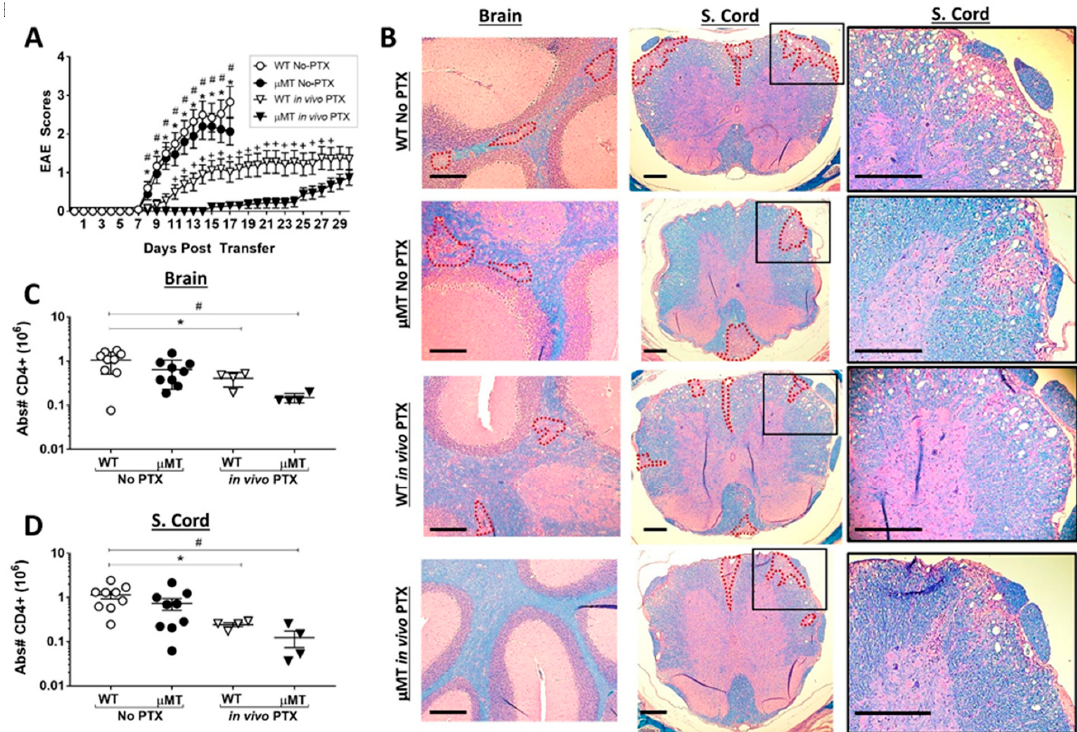
Figure 5. B-cell-deficient mice were protected against Th17-EAE when treated with PTX. ( A ) Clinical scores of WT and B-cell-deficient ( µ MT) mice with Th17-EAE treated with PTX (250 ng IP) (in vivo PTX) or PBS (No PTX) on day 0 and 2 post-transfer; n = 25–30/group; results compiled from 5 independent experiments. Mann–Whitney tests were performed between each group to determine statistical significance (* p < 0.05, WT No PTX vs. WT in vivo PTX; # p < 0.05 WT No PTX vs. µ MT in vivo PTX; + p < 0.05, WT in vivo PTX vs. µ MT in vivo PTX). ( B ) Representative brain and spinal cord sections of WT and µ MT mice stained with H&E and Luxol Fast Blue (regions enclosed with red dotted lines); scale bar 200 µ m. Absolute number of CD4 + T cells in the ( C ) brain and ( D ) spinal cord of WT and µ MT mice with PTX or PBS treatment; n = 8/group. Data representative of 2 independent experiments. One-way ANOVA was performed to determine statistical significance (* p < 0.05, WT No PTX vs. WT in vivo PTX; # p < 0.05 WT No PTX vs. µ MT in vivo